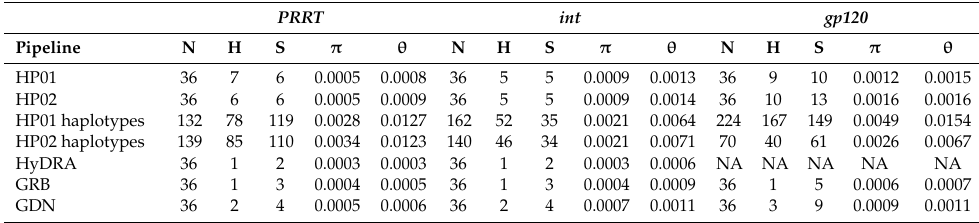
HyDRA is an average between read1 and read2. Abbreviations: HP01 = haphpipe_assemble_01 (de novo assembly), HP02 = haphpipe_assemble_02 (reference-based assembly), GDN = Geneious de novo assembly, GRB = Geneious reference-based assembly, N = number of sequences, H = number of haplotypes, S = number of polymorphic sites, π = nucleotide diversity, θ = Watterson’s genetic diversity, PRRT = protease and reverse transcriptase, int =